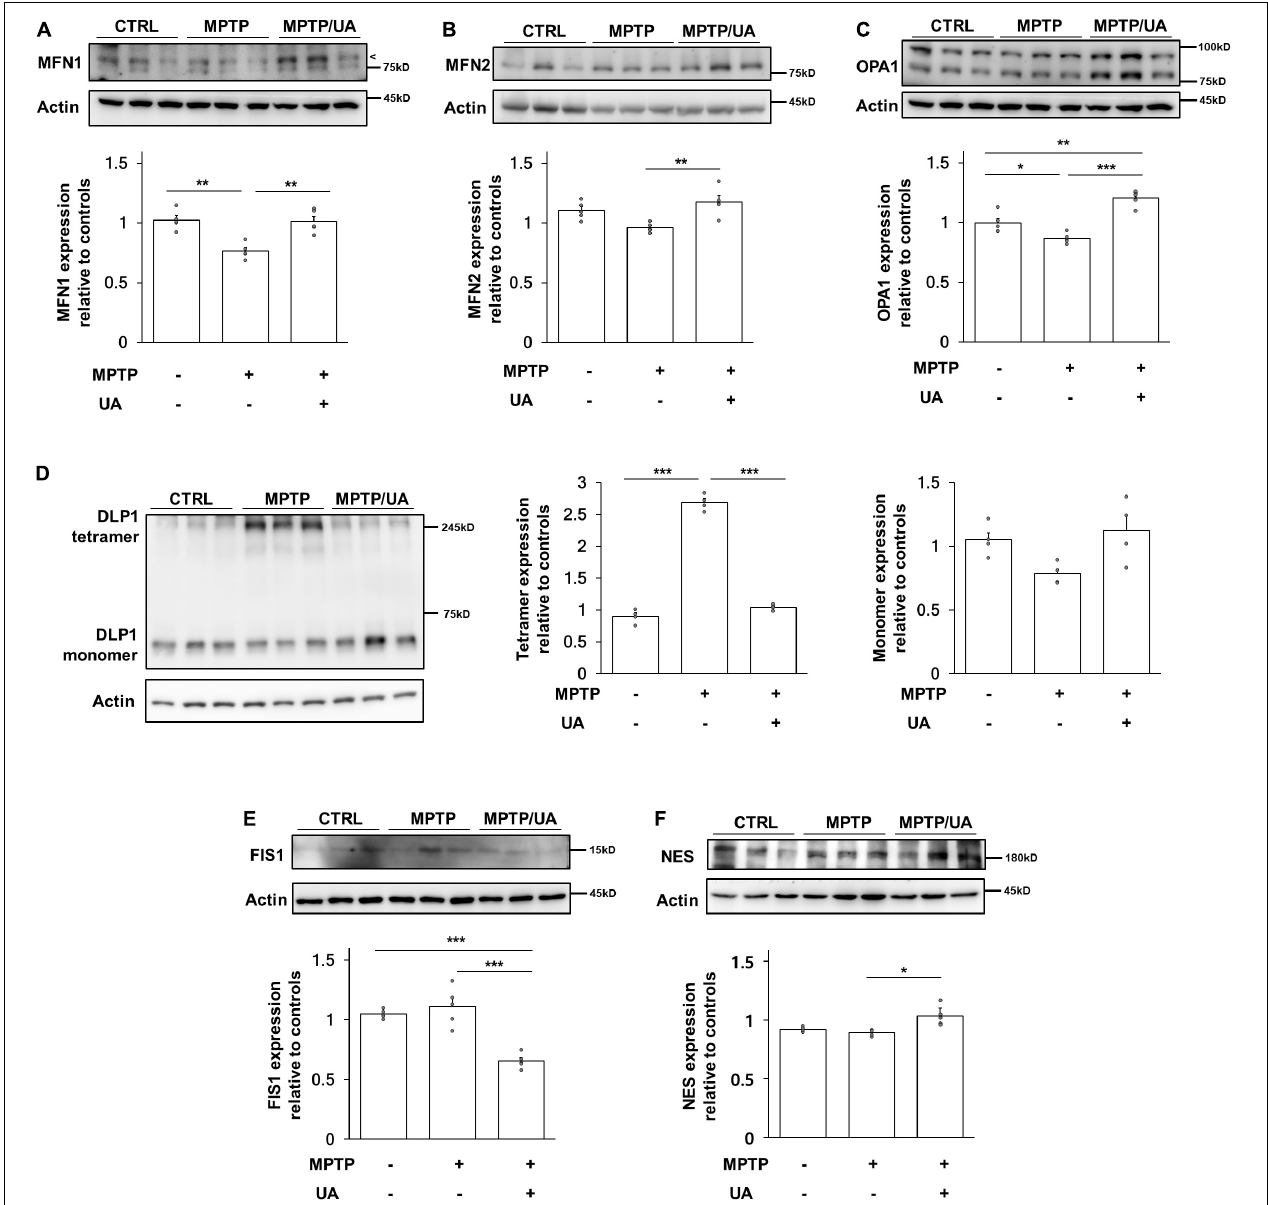
FIGURE 4 | PD mice with high serum UA level showed modulated mitochondrial dynamics. (A) Western blot for mitochondrial fusion marker, MFN1. (B) Western blot for mitochondrial fusion marker, MFN2. (C) Western blot for mitochondrial fusion marker, OPA1. The expression levels of MFN1, MFN2, and OPA1 were decreased in PD mice and upregulated in UA-elevated PD mice ( n = 5 per group). (D) Western blot for mitochondrial fission regulator Dlp1 tetramer and monomer form. (E) Western blot for mitochondrial fission marker, FIS1. The expression level of Dlp1 tetramer form and FIS1 were increased in PD mice and significantly suppressed in PD mice with high serum UA levels ( n = 5 per group). (F) Western blot for neural stem cell marker, NES. The expression levels of NES were significantly increased in UA-elevated PD mice compared to control or PD mice with normal UA levels ( n = 5 per group). Differences among the conditions were evaluated by ANOVA with a Bonferroni correction for multiple comparison. The data are presented as mean ± SE. * p < 0.05, ** p < 0.01, and *** p <